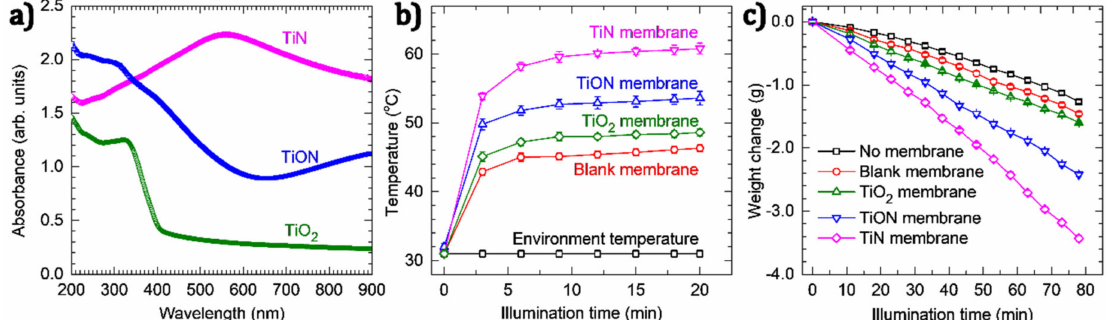
Figure 3. ( a ) UV–VIS absorption spectra of TiO 2 , TiON and TiN nanodonuts, ( b ) temperature at the surface of membranes under simulated solar light with illuminance of 550 W m –2 , and ( c ) the weight change due to water evaporation by different photothermal